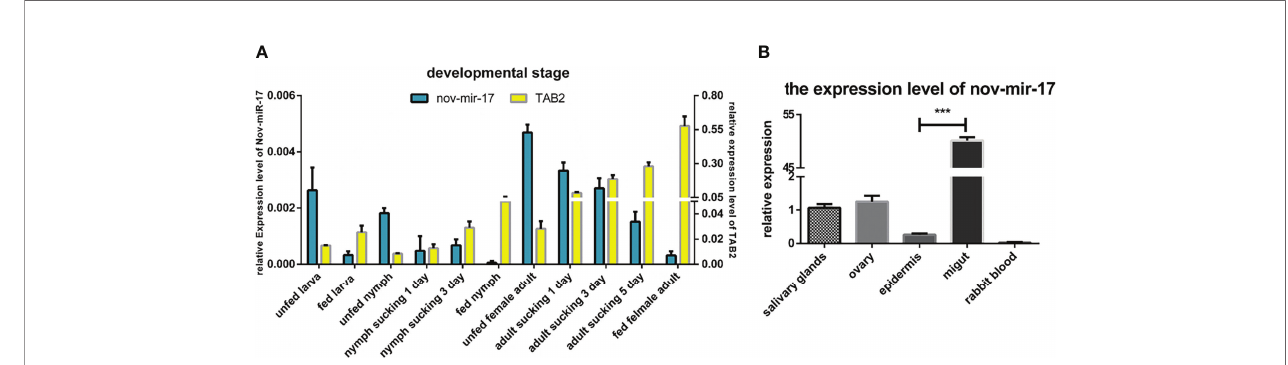
FIGURE 3 | (A) Expression of nov-mir-17 and TAB2 at different developmental stages. (B) miRNA expression in different tissues of fed ticks. The data are presented as the means ± SEMs of triplicate samples.